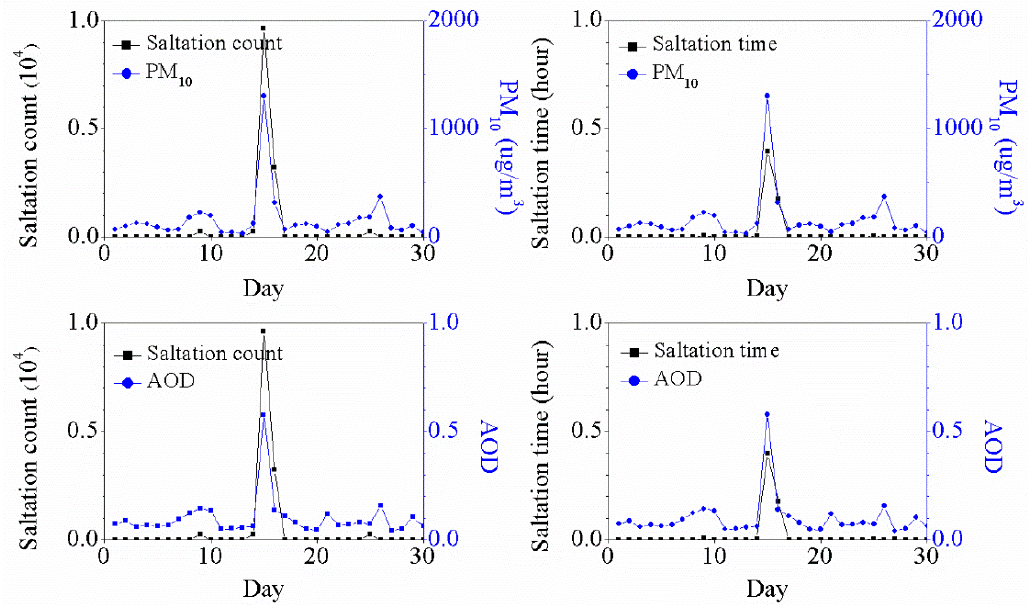
Figure 11. Daily saltation time, saltation count, PM 10 , and AOD observations during November 2009.